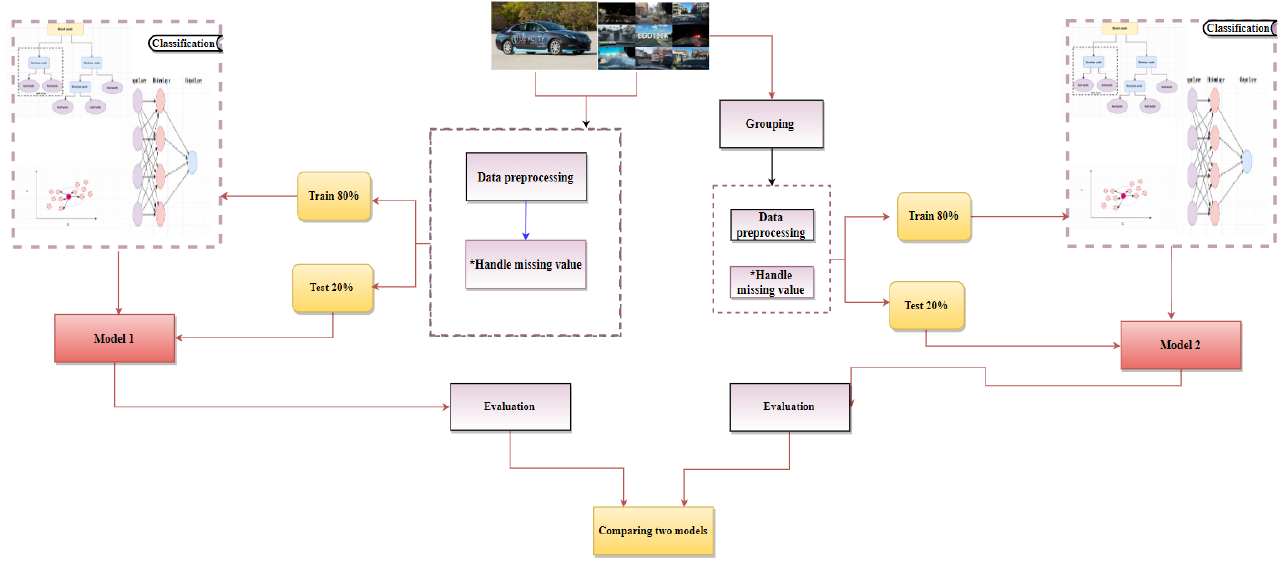
Figure 4. The methodology model of the proposed